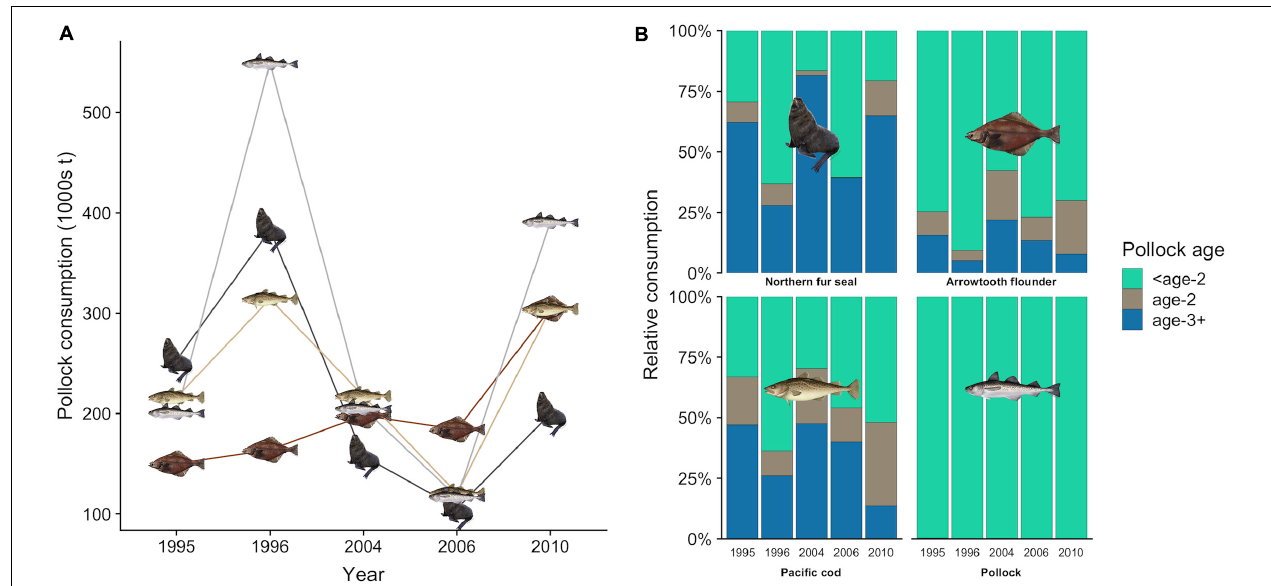
FIGURE 5 | Total estimated consumption of walleye pollock by northern fur seals, pollock, arrowtooth flounder, and Pacific cod in each year (A) , and the percentage contribution of pollock age classes to each predator’s consumption (B) . In (B) , pollock age estimates for fish predators were derived from the multispecies CEATTLE model (Holsman et al., 2016, 2019). Age-specific consumption of pollock by fur seals was based on fork length size classes: < age-2 (2.0–19.4 cm), age-2 (19.5–29.4 cm), and age-3 + ( > 29.4